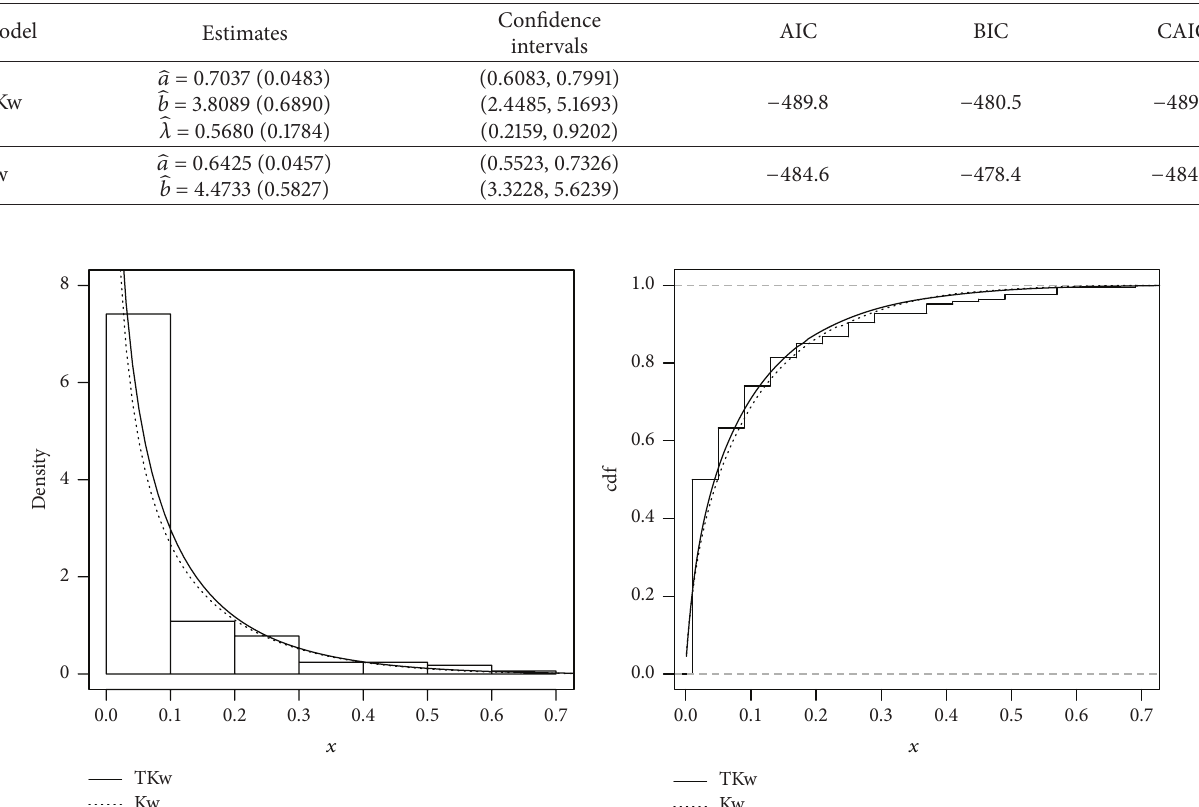
Table 4: Estimates of the parameters (standard errors in parentheses), goodness-of-fit statistics, and confidence intervals with significance level at 5 % for the data set.